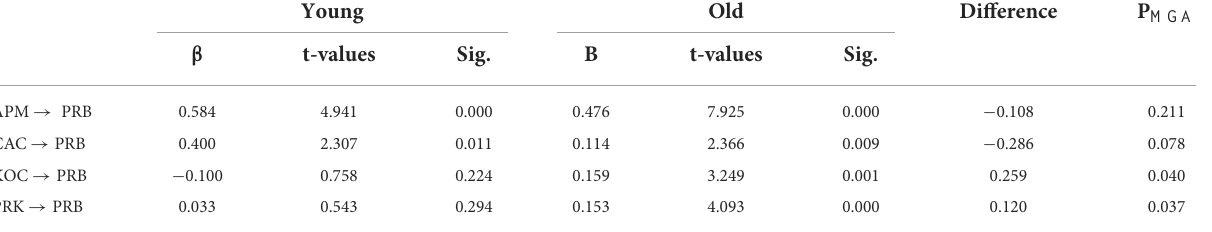
TABLE 13 Multiple group comparison based on age.